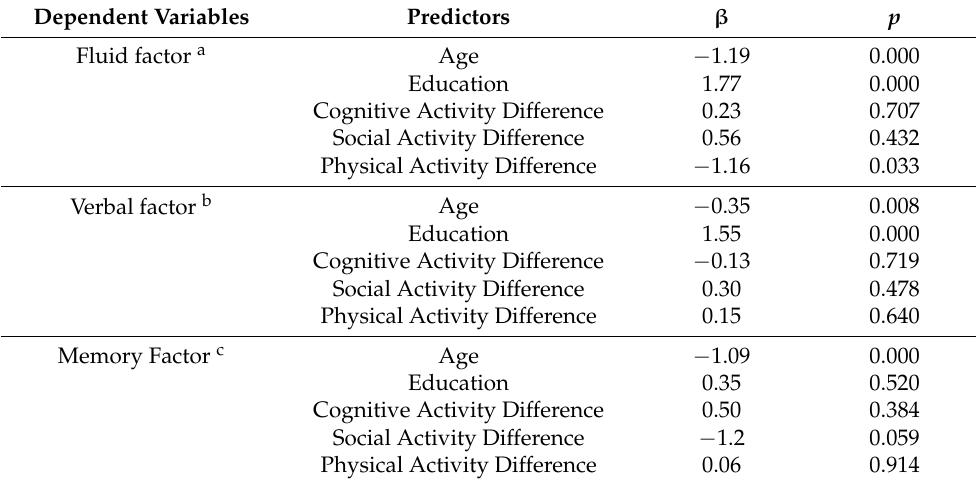
Table 6. Multivariate Multiple Regression Standardized Coefficients for Activity Domain Difference Scores, Age, and Education Predicting Cognitive